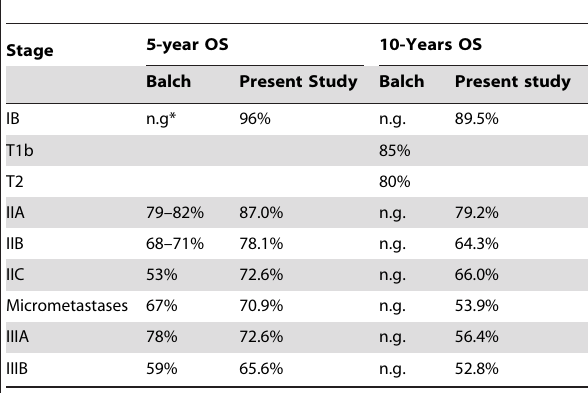
Table 2. Five and 10-year melanoma-specific survival in sentinel node-staged cutaneous melanoma patients (n=1909). compared to in 27,000 stage I/II and 2,587 stage IIIA/B patients reported by Balch et al. [15,18].